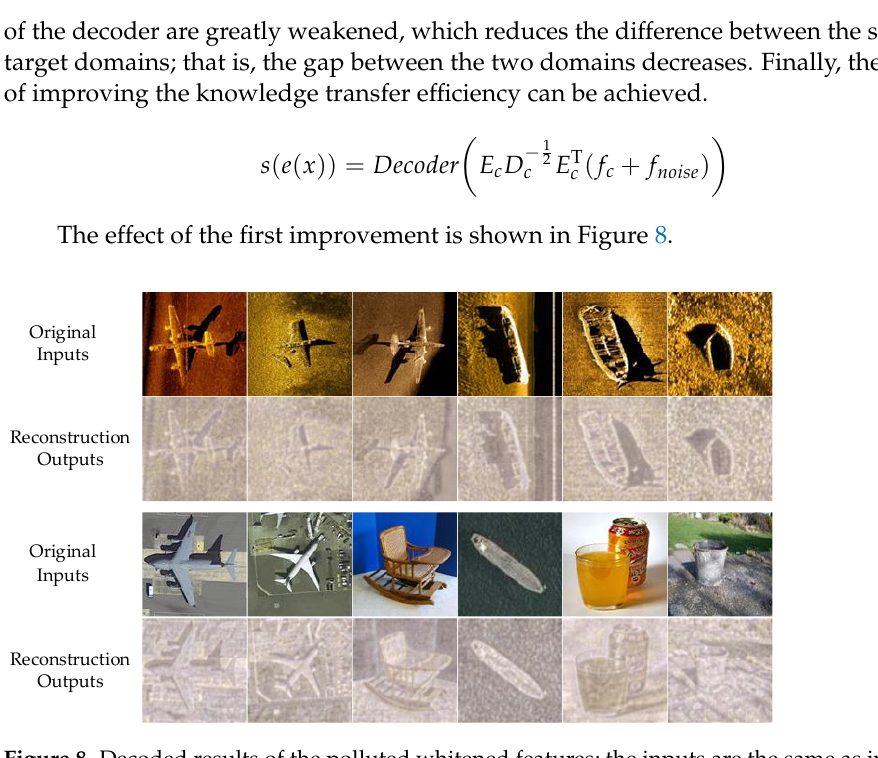
9 of 21 Figure 7. Results of decoding the low-frequency and high-frequency of deep feature: ( a ) is the original input image, ( b ) is the reconstruction image of whitening transform, ( c ) is reconstruction